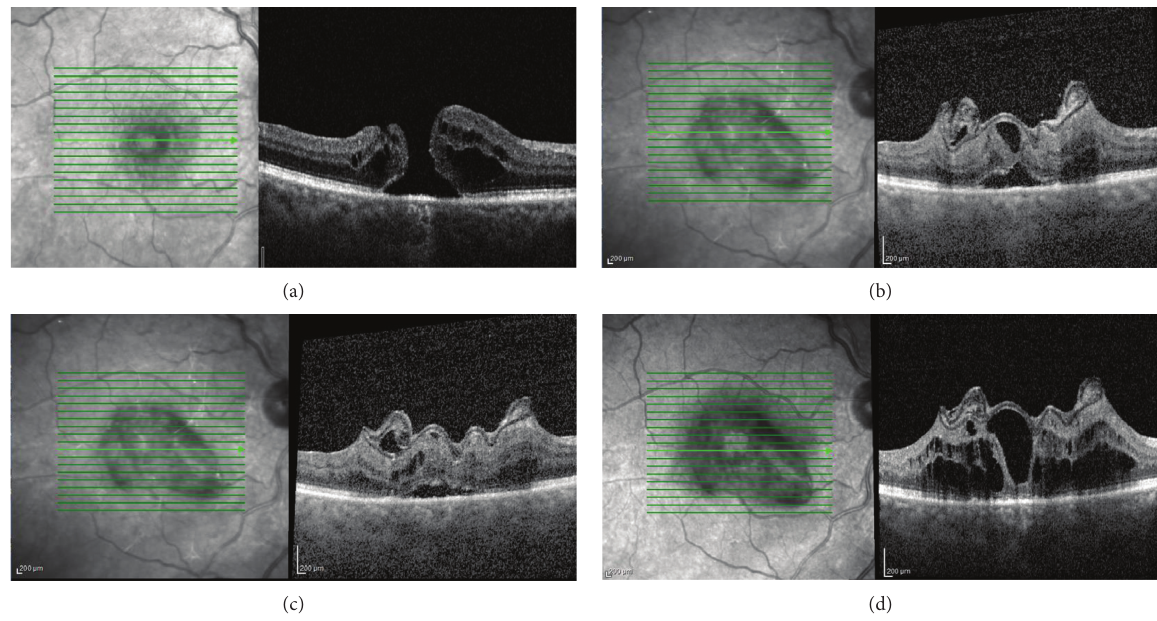
Figure 4: Macular hole closure over time after anterior lens capsular flap transplantation. Vertical SD-OCT scans: (a) baseline, (b) one month after surgery, (c) six months postoperatively, and (d) 12 months postoperatively. Scale bar � 200 µ m.